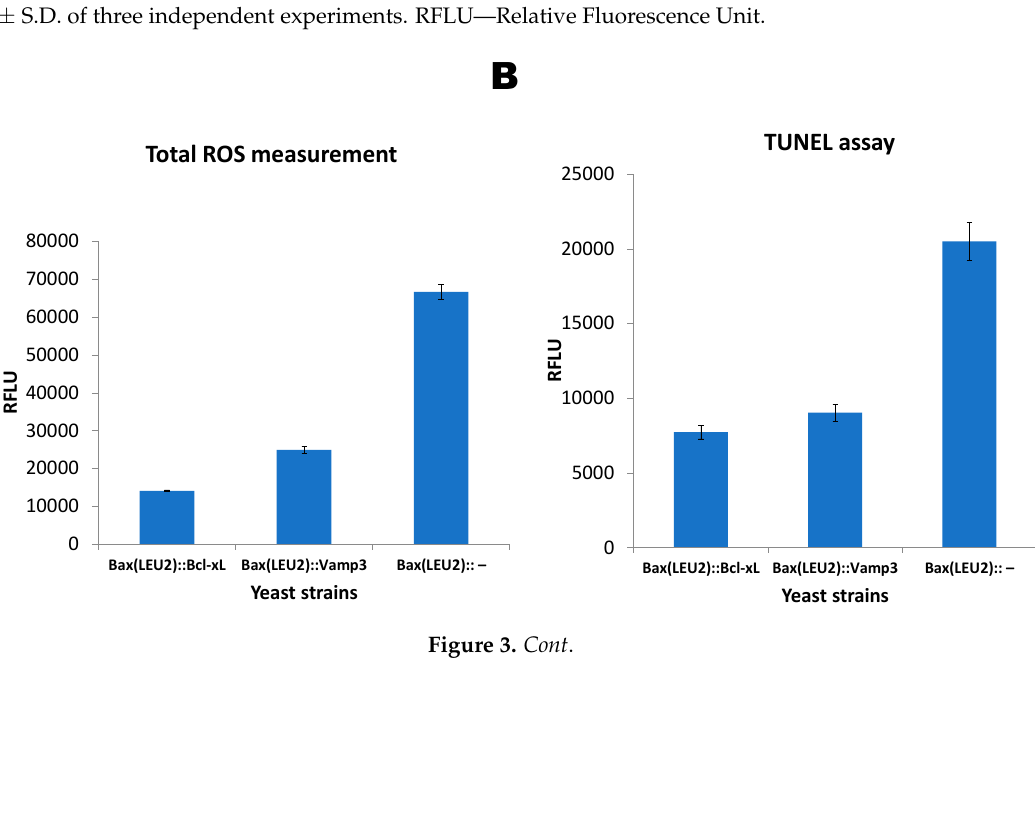
Figure 3. Reactive oxygen species (ROS) measurement, terminal deoxynucleotidyl transferase (TdT)-facilitated dUTP nick end labelling (TUNEL) assay, and Western blotting. ( A ) Measurement of ROS produced in the yeast strains Bax(LEU2) + VAMP3, Bax(LEU2) + Bcl xL, and Bax(LEU2) –. A two way ANOVA test shows that there was a significant difference ( p < 0.05) between the control strain and each of Bax + VAMP3 and Bax + Bcl-xL, but there was no significant difference ( p > 0.05) between Bax + VAMP3 and Bax + Bcl-xL. The data represent the mean ± S.D. of three independent experiments. ( B ) TUNEL assay comparing the nuclear DNA fragmentations in yeast strains Bax(LEU2)VAMP3, Bax(LEU2)Bcl xL, and Bax(LEU2). The cells Bax(LEU2)VAMP3 and Bax(LEU2)Bcl xL have lower nuclear DNA fragmentation compared to Bax(LEU2)–cells. A two way ANOVA test shows that there was a significant difference ( p < 0.05) between the control strain and each of Bax + VAMP3 and Bax + Bcl-xL, but there was no significant difference ( p > 0.05) between Bax + VAMP3 and Bax + Bcl-xL. The data represent the mean ± S.D. of three independent experiments. ( C ) Represent the microscopic image of cells after tunnel assay, Bax(LEU2)VAMP3 and Bax(LEU2)Bcl xL . The left images are representative of cells under flu- orescent light, showing dead cells (red) (high nuclear fragmentation) . ( D ) Western blot to monitor the presence of Bax in yeast cells that express only Bax and in cells that coexpress Bax together with VAMP3 and, Bcl-xL. Of total cellular proteins,